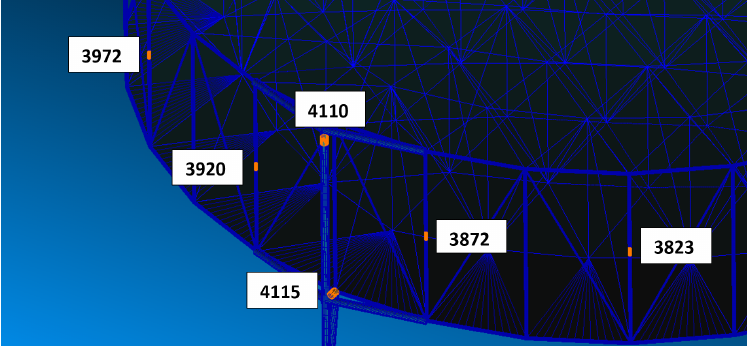
Figure 3. Possible damage location on the reflector structure (labels are used to identify the element in which the failure can occur).